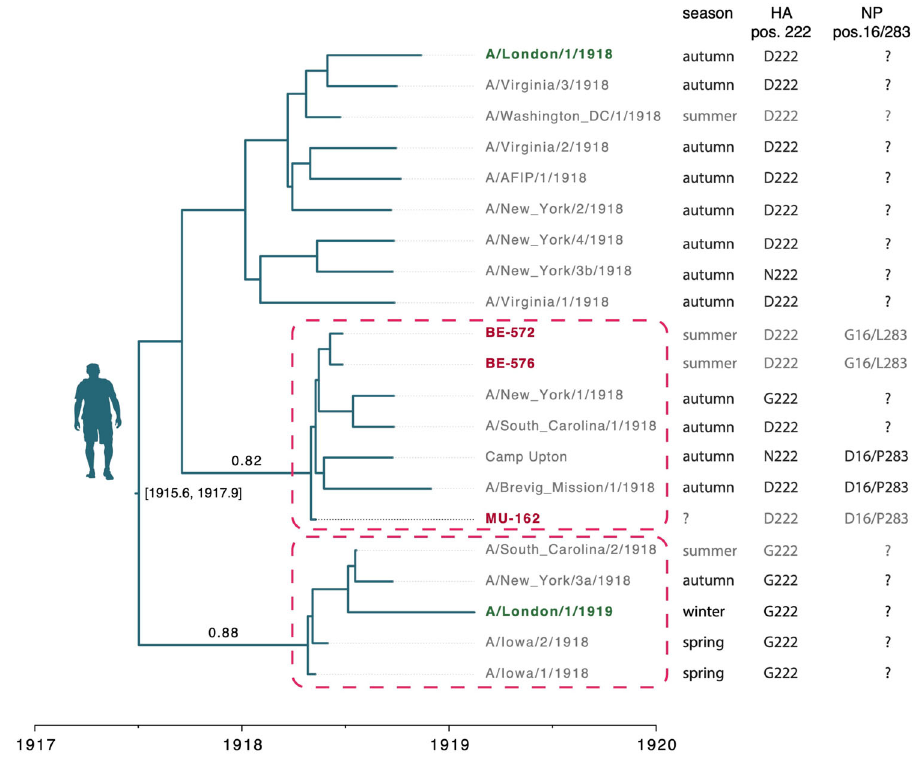
Fig. 3 Time-scaled phylogeny reconstructed based on HA sequences from 1918 fl u strains. US sequences are in gray, European sequences are in dark red (Germany) and dark green (UK). Dashed rectangles highlight clades comprising strains from different continents and with posterior support ≥ 0.75; for these clades posterior probabilities are reported above stem branches. The season column indicates from which season the samples originate, with light gray for the pre-pandemic peak period (spring and summer) and dark gray for the pandemic peak period (autumn and winter). The amino acid residues at HA position 222 and NP positions 16 and 283 are also indicated. ‘ ? ’ indicate the absence of information. Numbers between brackets next to the root node indicate the 95% Highest Posterior Density (HPD) of its estimated age. The BE-576 consensus genome with ambiguities was used in this analysis; an equivalent reconstruction using majority rule consensus base calling can be found in Supplementary Fig.